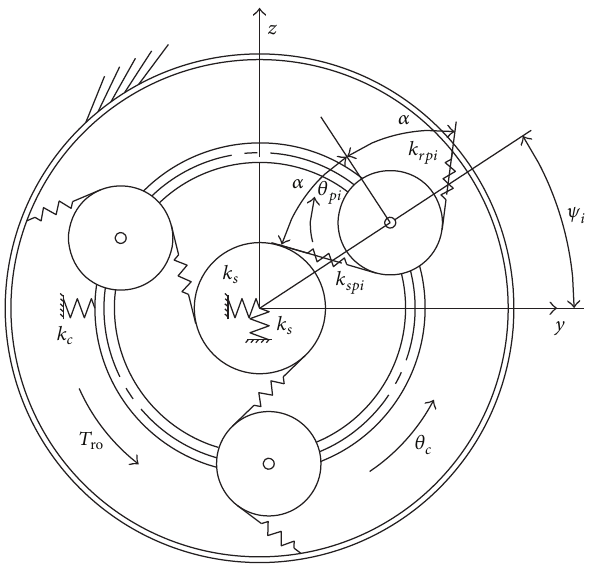
Figure 1: Components of a